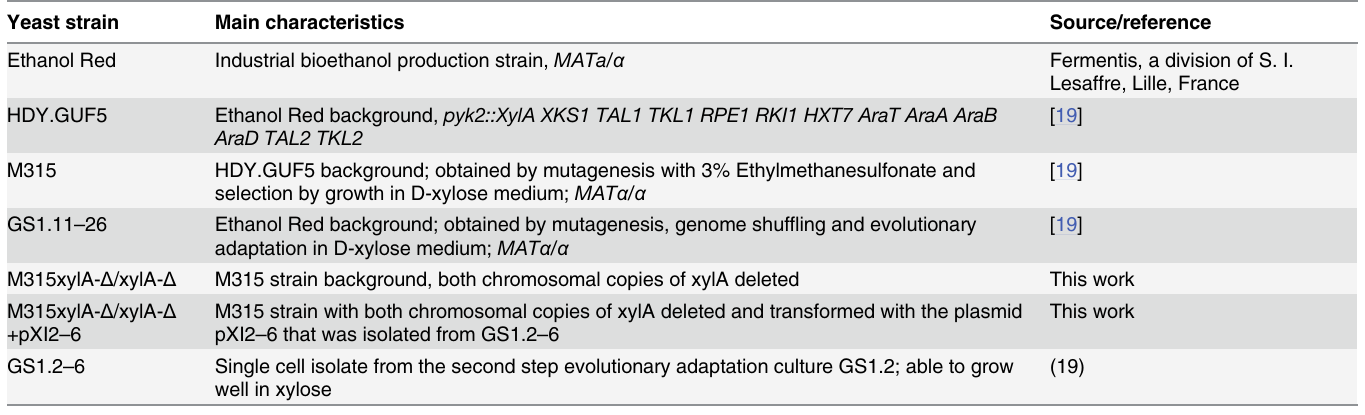
Table 1. S. cerevisiae strains used in this